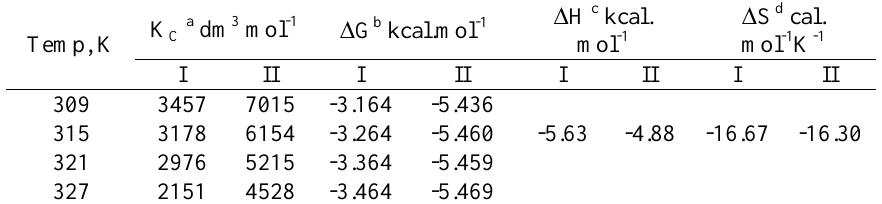
Table 1. Thermodynamic parameters for AO-NaCar &MB-NaCar systems